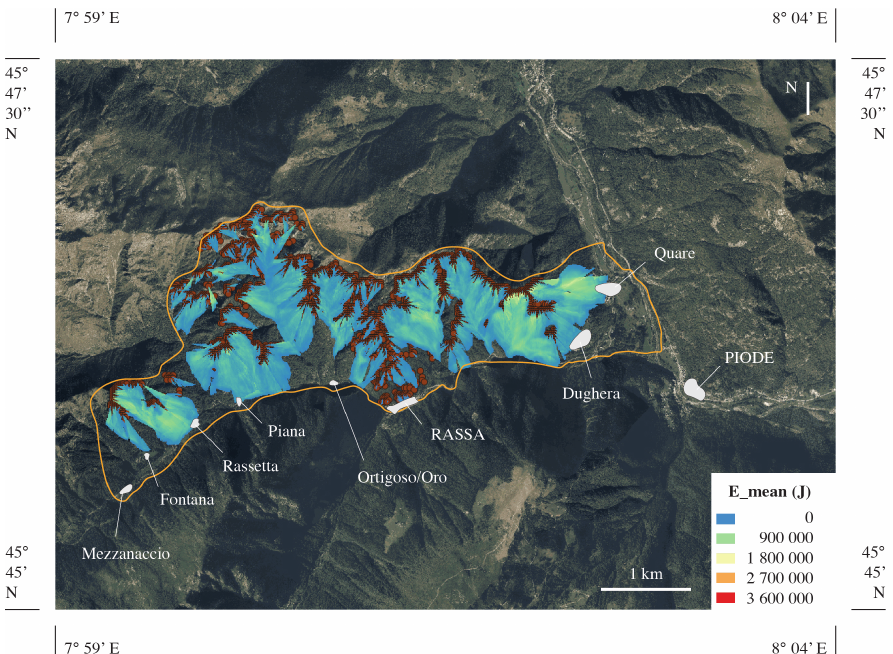
Figure 6. Mean energy map for the forecasting analysis of the 0.5 m 3 rockfall scenario.